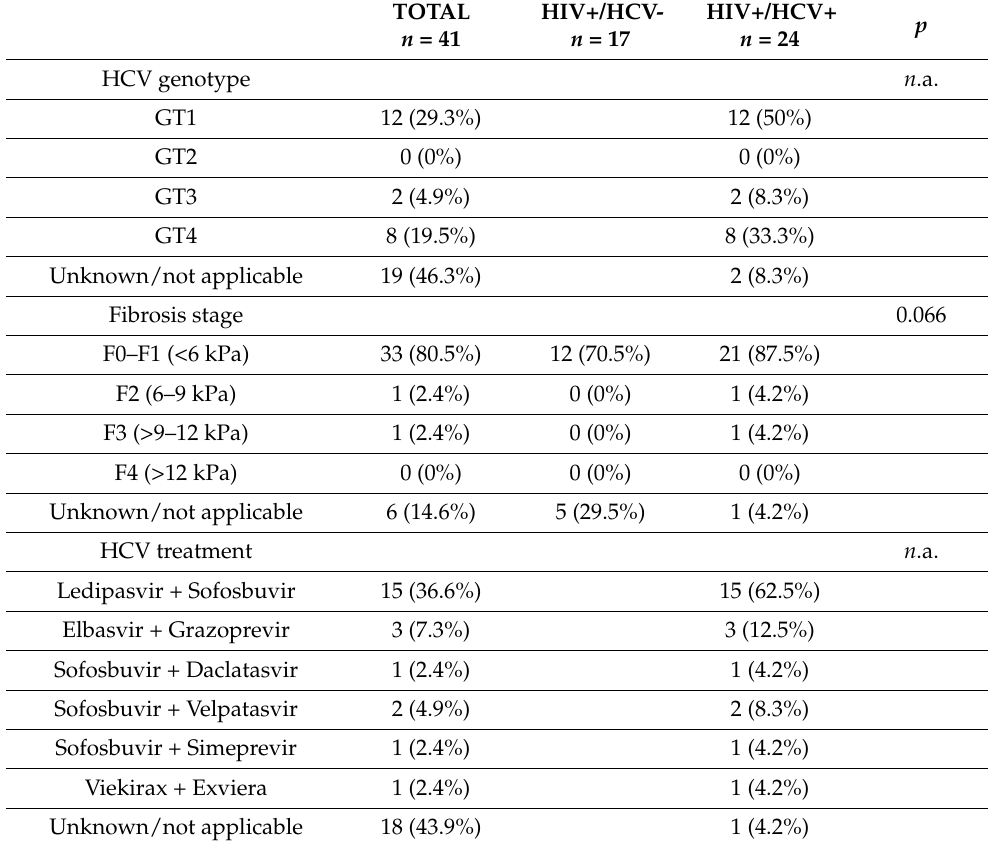
Table 3. Clinical characteristics of the study population related to HCV